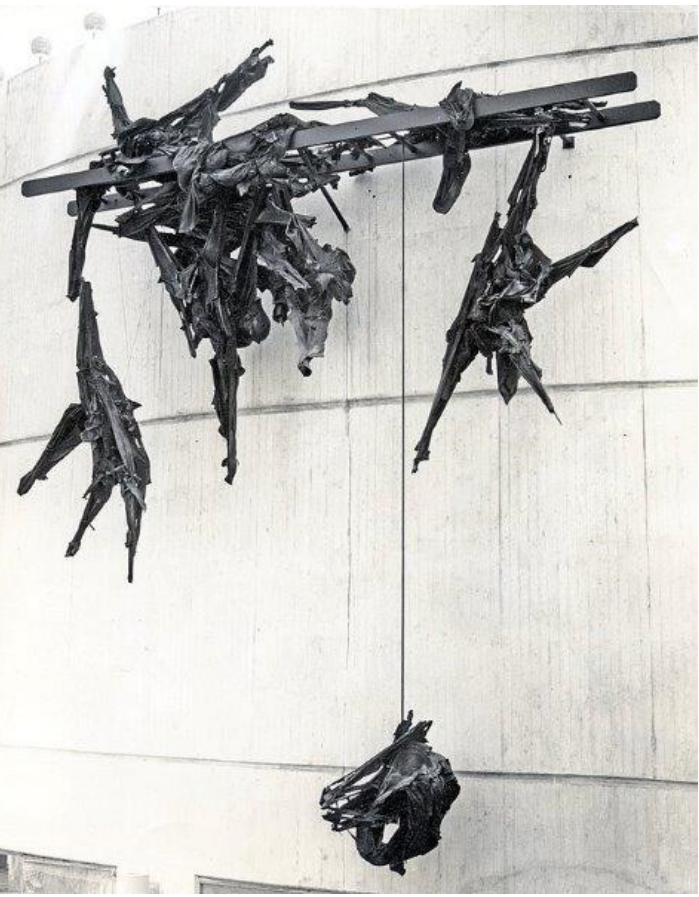
Figure 7. Robert Mallary, Cliffhangers , 1964–1965. 20 ft. × 20 ft. Plastic impregnated tuxedoes with wood and welded steel. Installation view exterior New York State Pavilion, New York World’s Fair, 1964–1965. Image courtesy of estate of the artist.